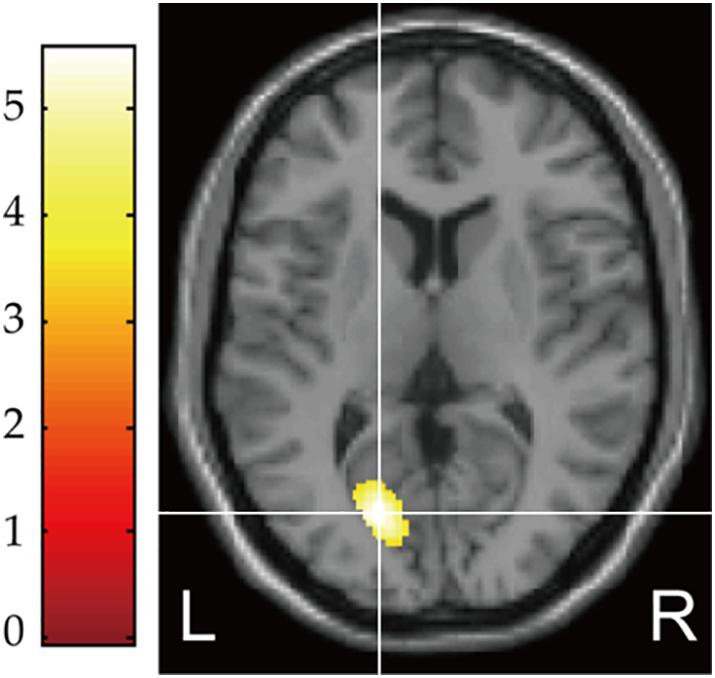
Structural differences in regional gray matter (GM) volume between the typically developing (TD) and reactive attachment disorder (RAD) groups. The RAD group showed significantly reduced GM volume in the left primary visual cortex (BA 17) compared to the TD group (p = 0.038, FWE-corrected cluster level). Color scales represent t-values.